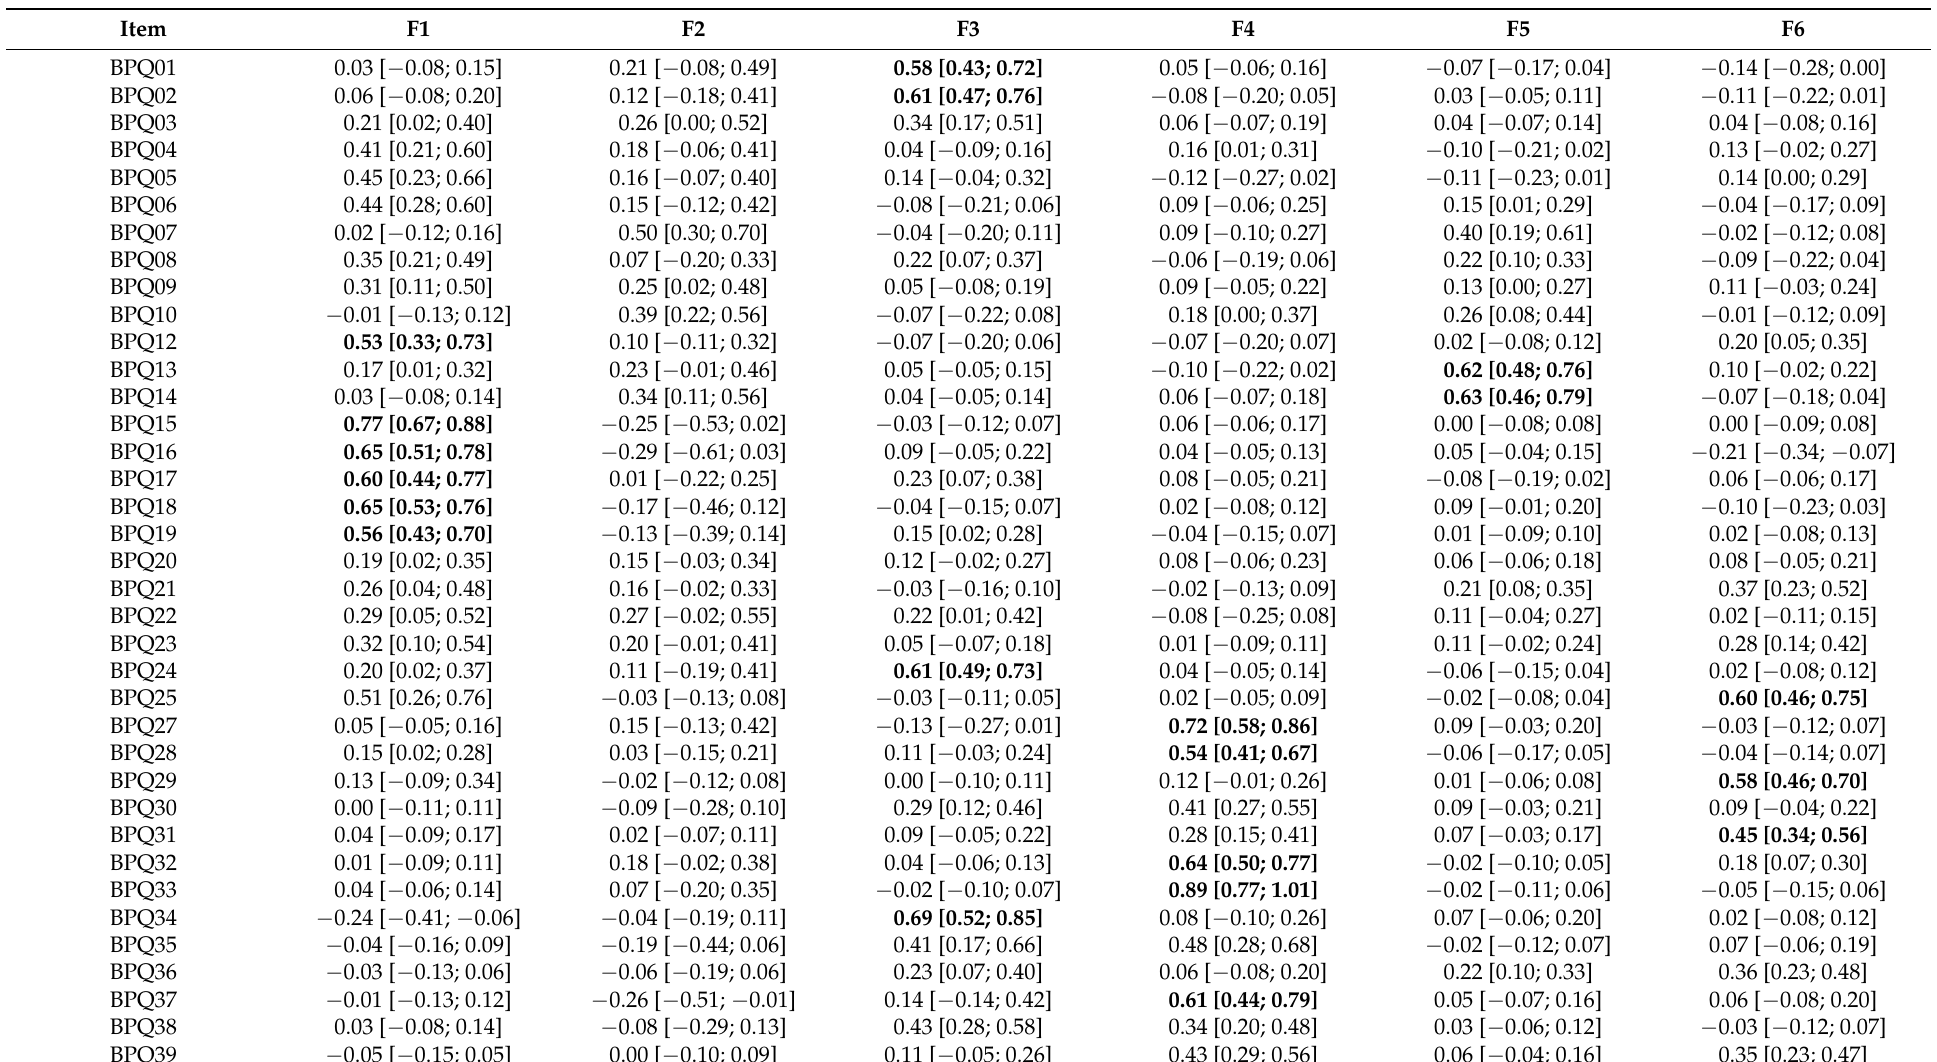
Table 3. Loading matrix and factor correlations of the six-factor exploratory structural equation modeling solution (data from the first random subsample, n =